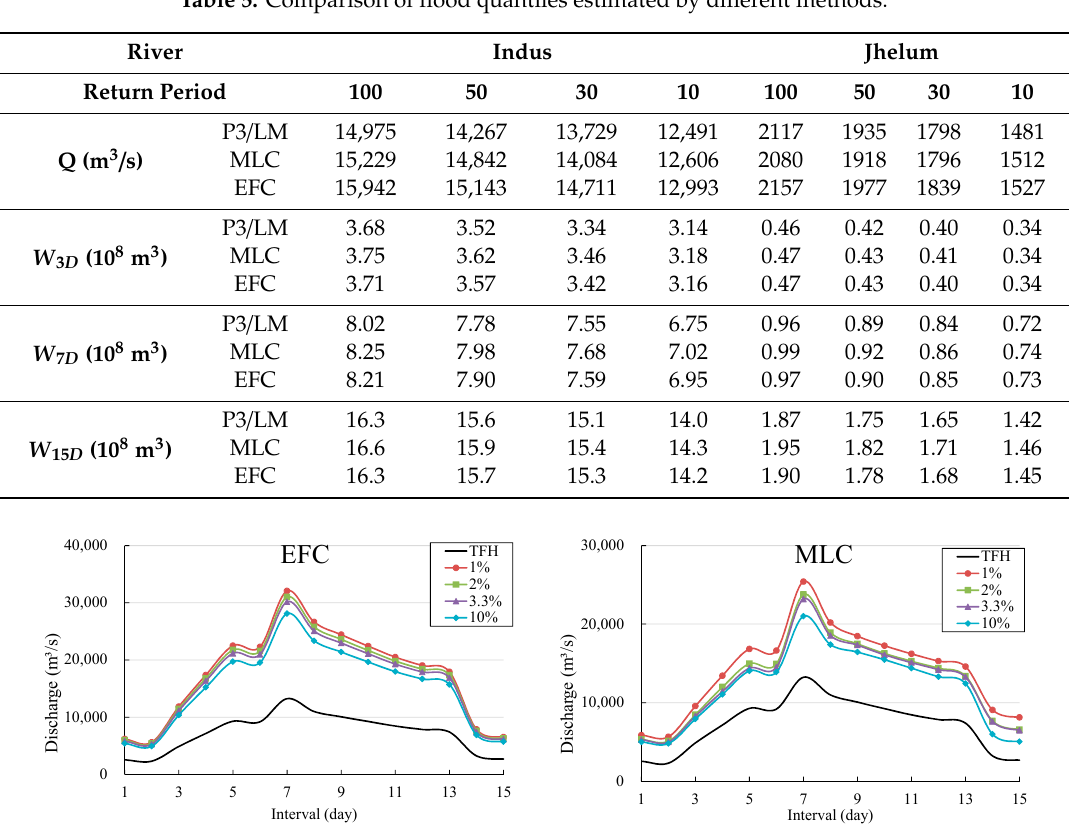
Figure 6. DFH derived by equal frequency combination (EFC) method and most likely combination (MLC) method at Indus river.